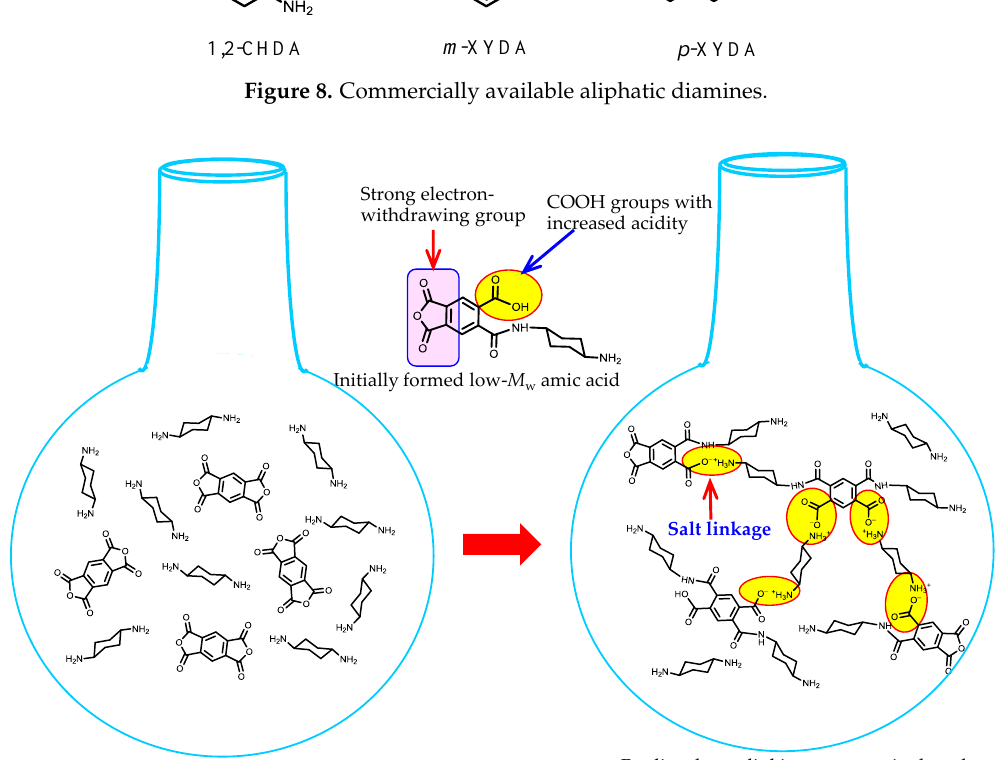
Figure 9. A schematic illustration of salt formation in the initial stage of PAA polymerization in